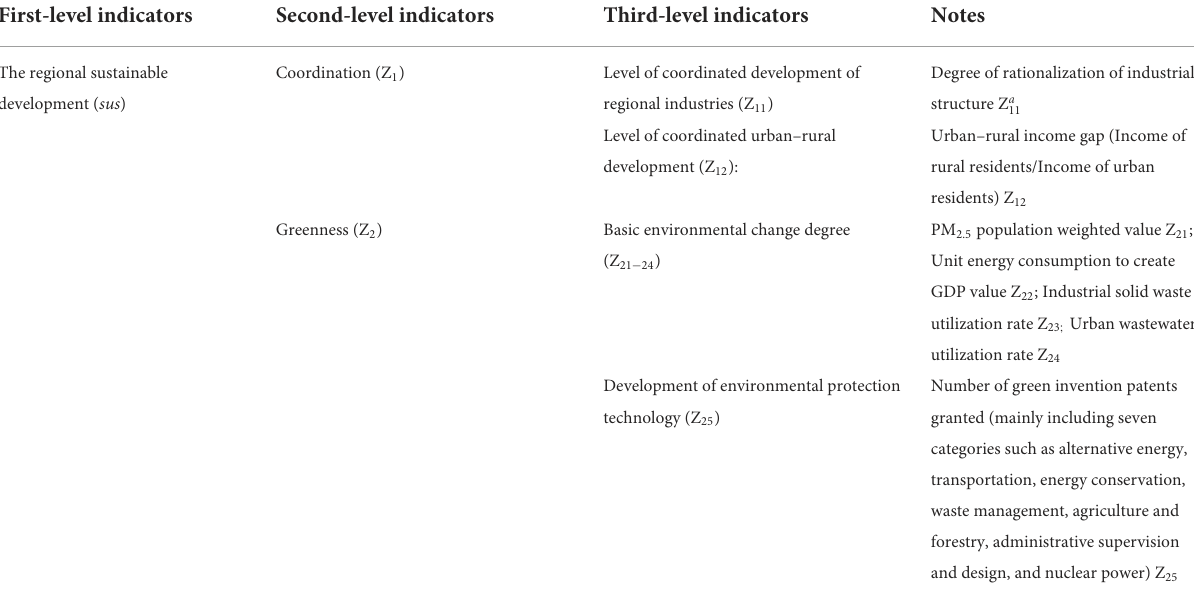
TABLE 1 Index of regional sustainable development level.